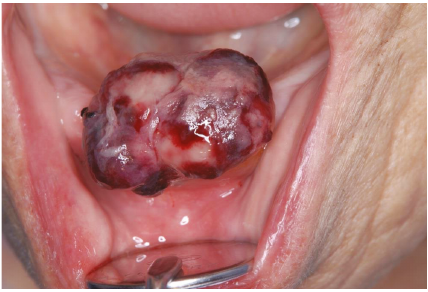
Figure 1: The hematocele on the gingiva area (after tooth 32 extraction). Photo of a mass on